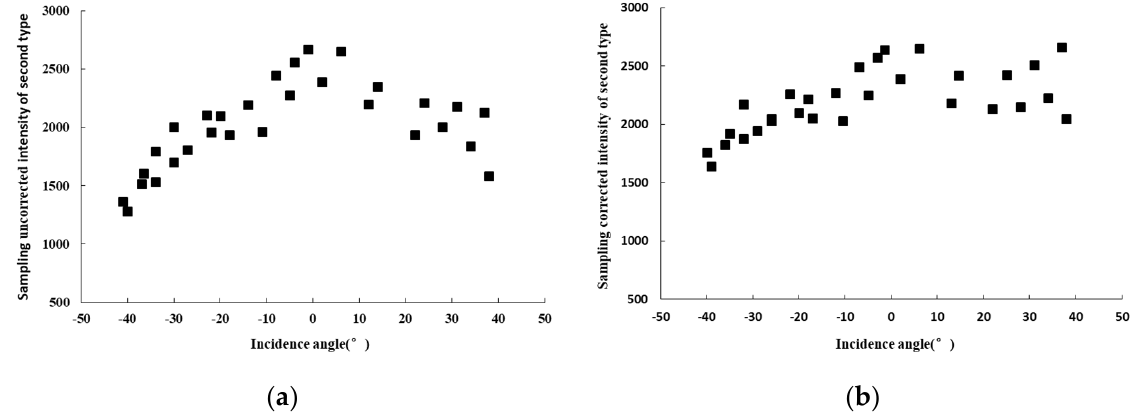
Figure 10. Results for strip 2: ( a ) the original intensity values (the amplitude); ( b ) the corrected intensity values by elimi- nating the effects of incident angle and range.